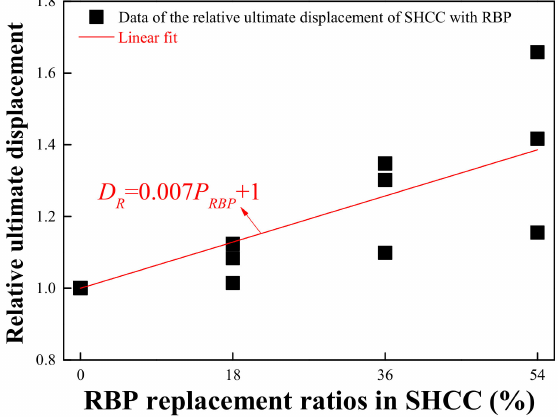
Figure 13. Relationship between the ultimate displacement of SHCC and and RBP